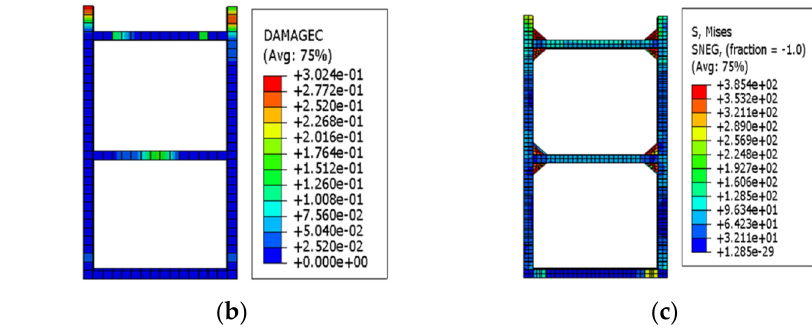
Figure 7. Stress contour plots at a drift ratio of 1/200. ( a ) Stress contour plot of the wall concrete; ( b ) stress contour plot of the concrete in the boundary steel tube; and ( c ) von Mises stress contour plot of the boundary steel tube.